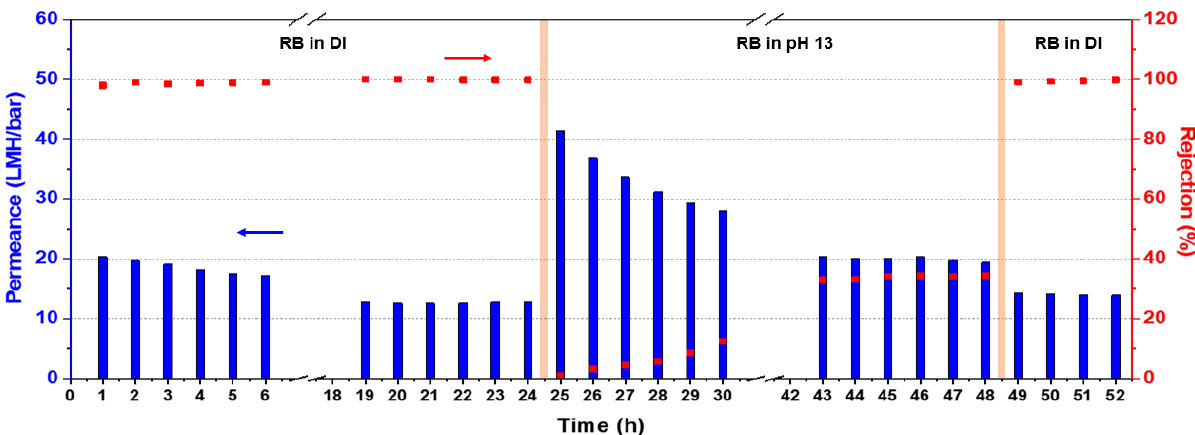
Figure 8. Water permeance and RB rejection profiles of the crosslinked PBI membrane at both neutral and pH 13 conditions.